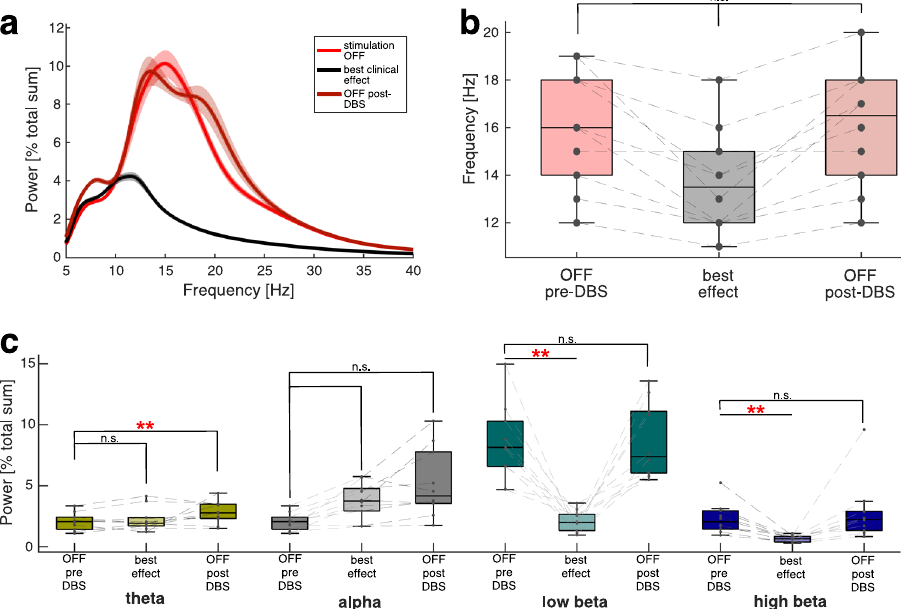
Fig. 3 Chronic DBS suppresses beta frequency band activity. a Mean power spectra are grouped according to clinical effect of stimulation as measured by fi nger tapping showing that effective stimulation suppresses beta-band activity. b Peak beta-band amplitude is suppressed during effective DBS and spectral peaks are shifted towards lower frequencies (mean peak frequency OFF: 16 ± 2.5 Hz; mean peak frequency ON: 13.7 ± 2.16 Hz, mean peak frequency post-DBS: 16 Hz ± 2.5 Hz), with no signi fi cant differences). c Stimulation modulates mean power spectra in a frequency-speci fi c manner with signi fi cant suppression of low and high-beta-band power but not alpha or theta band activity. Boxplots with median as the central mark, 25th/75th percentile as edges. Low-beta-band (13 – 20 Hz) and high-beta-band activity (20 – 35 Hz) was signi fi cantly suppressed through DBS at the stimulation intensity for best clinical effect (low-beta OFF-DBS: 8.43±3.14 [% total sum]/best clinical effect: 2.11 ± 0.85 [% total sum]; p = 0.002; mean high-beta OFF-DBS: 2.32 ± 1.3 [% total sum], mean high-beta best clinical effect: 0.66 ± 0.25 [% total sum], p = 0.002), no signi fi cant modulation in the theta (5 – 8 Hz) and alpha (8 – 12 Hz) band activity (OFF/best clinical effect, mean theta OFF-DBS: 2.04 ± 0.71 Power [% total sum], mean theta best clinical effect: 2.24 ± 0.96 Power [% total sum]; p = 0.26, mean alpha OFF-DBS: 4.65 ± 3.6 Power [% total sum], mean alpha best clinical effect: 3.79 ± 1.43 Power [% total sum]; p =